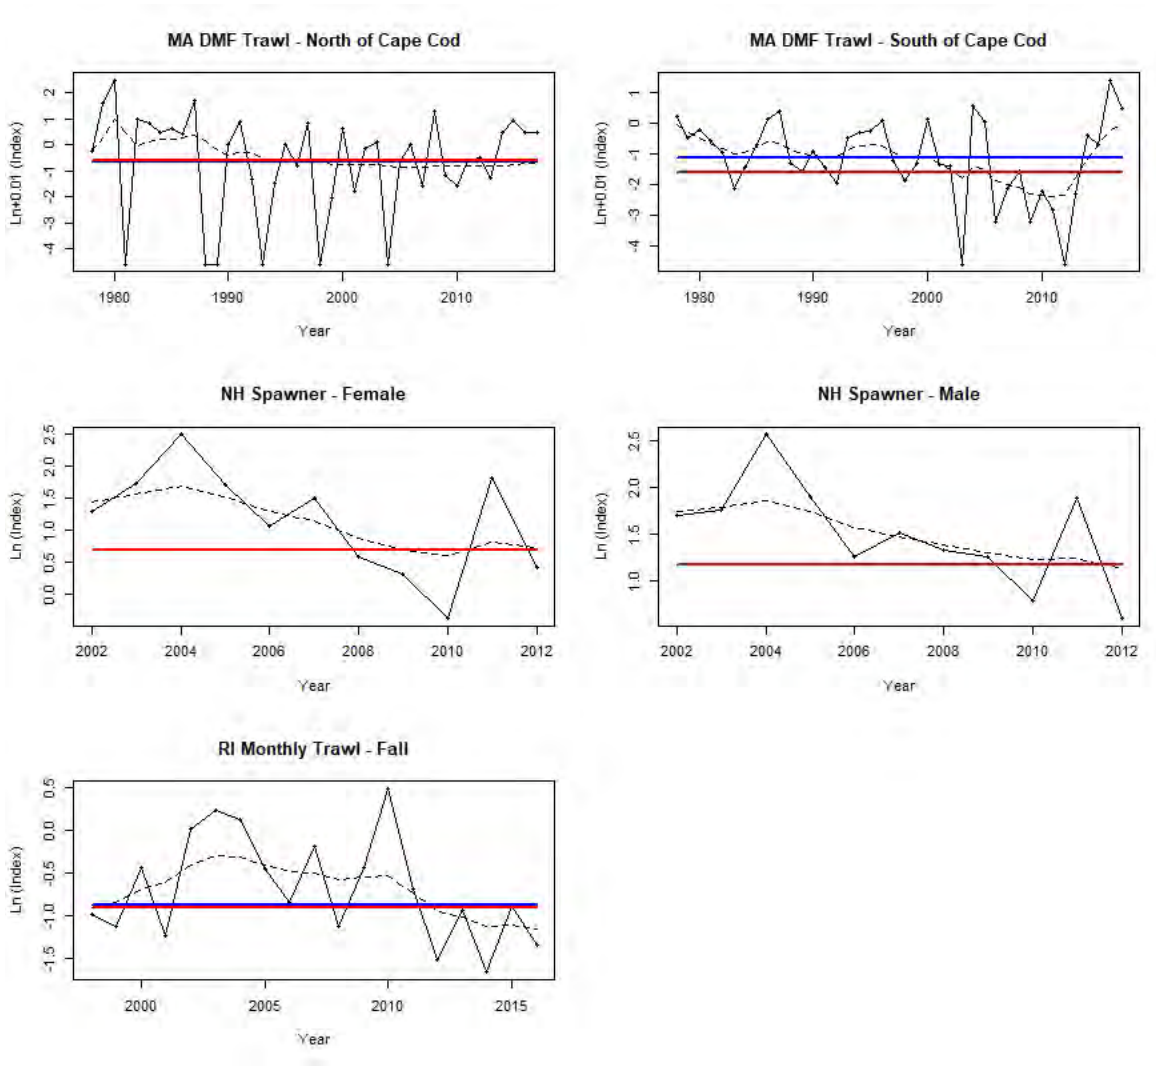
Figure 83. Northeast Region horseshoe crab survey ARIMA model fits. The solid line represents the observed ln transformed indices and the dashed line represents the fitted indices. The red horizontal line represents the Q 25 reference point and the blue horizontal line represents the 1998 reference point. Note: The residuals from the ARIMA model fit to the MA DMF Trawl – North of Cape Cod were not normally